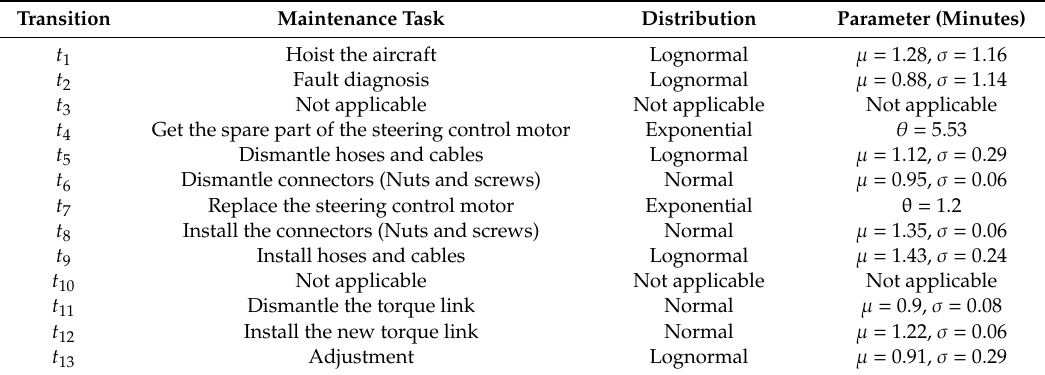
Table 1. Detailed information of